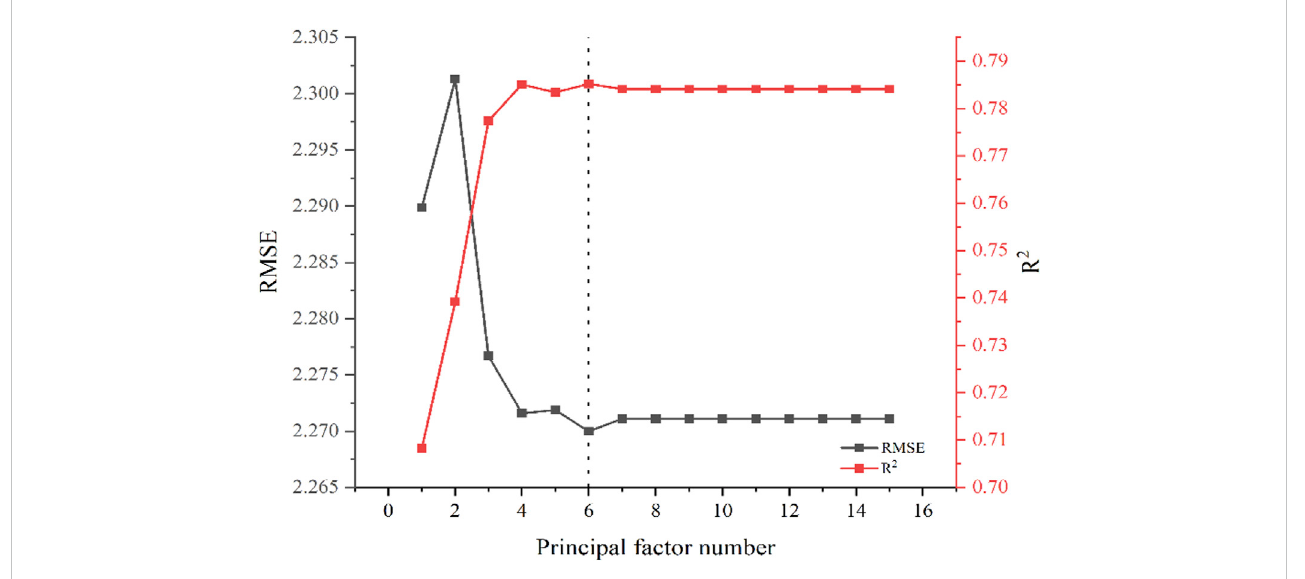
The relationship between principal factor number and R 2